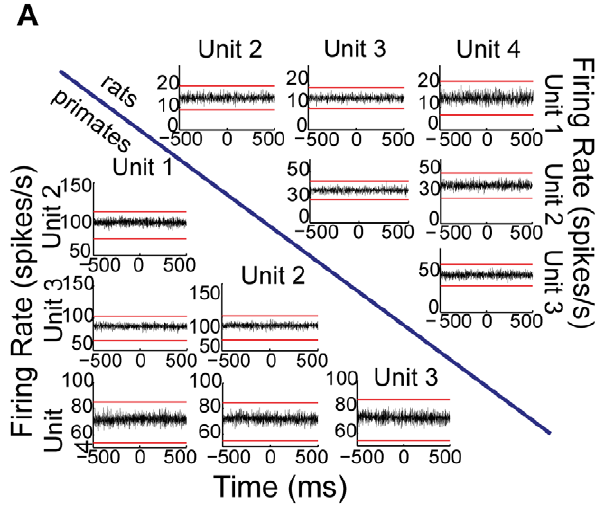
Figure 5. GPe neurons exhibit negligible interactions between pairs of neurons. Cross-correlations in the two species. Below the blue line: cross-correlations during a time window of 6 1 s in four units recorded simultaneously in primates. Above the blue line: same in rats. Red lines in every cross-correlogram represent the lower and upper confidence levels (see Methods).